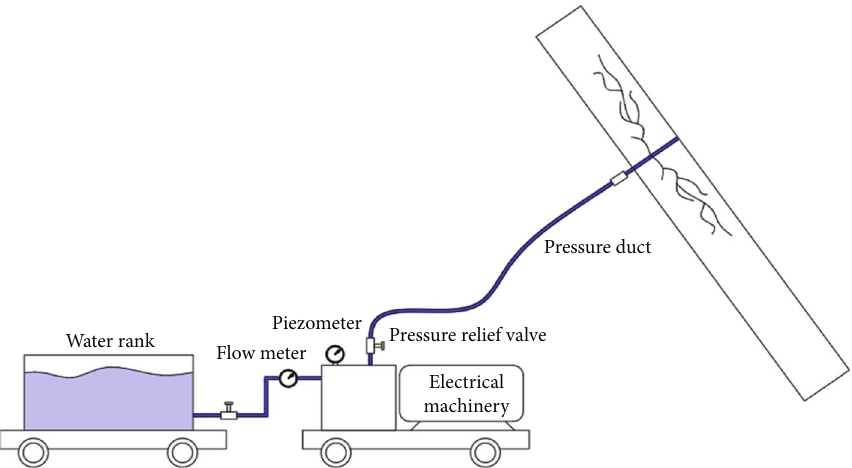
Figure 12: Schematic diagram of the hydraulic perforation and fracturing permeability-increasing system.